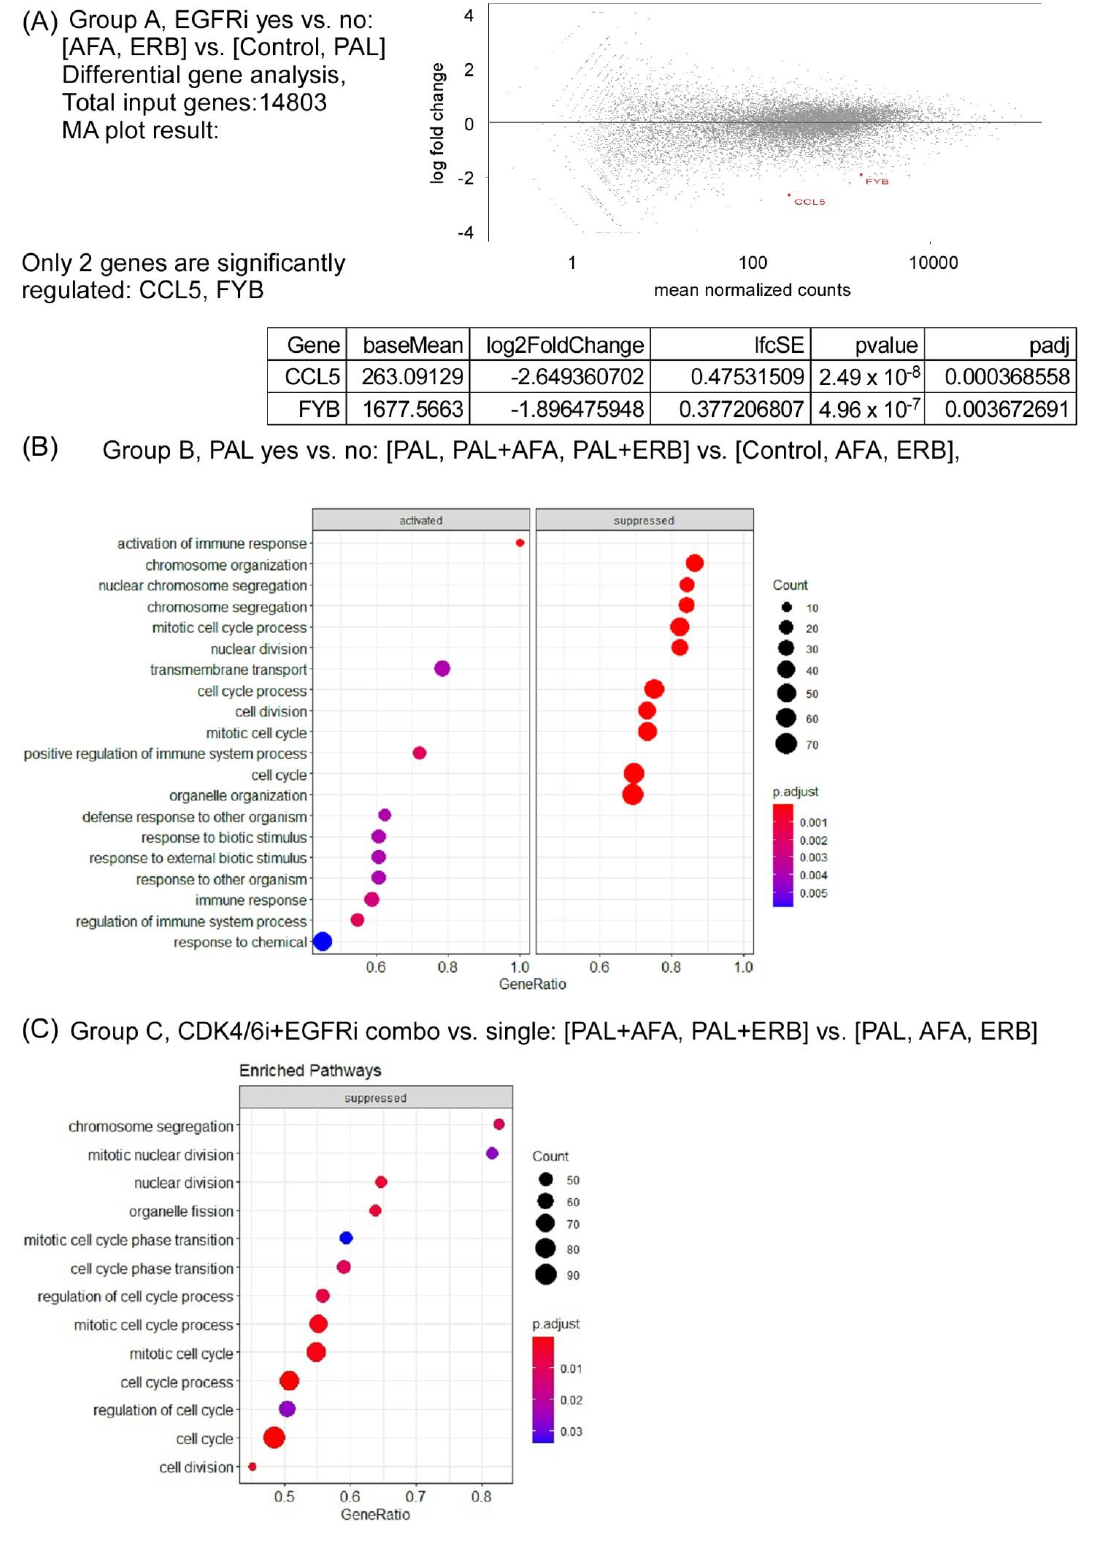
Figure 6. Bulk RNA sequencing of NPC PDX with or without EGFRi and/or CDK4/6i treatment. ( A ) Group A, EGFRi yes vs. no: (AFA and ERB0 vs. (Control and PAL); ( B ) group B, PAL yes vs. no: (PAL, PAL + AFA, and PAL + ERB) vs. (Control, AFA, and ERB); ( C ) group C, CDK4/6i+EGFRi combo vs. single: (PAL + AFA and PAL + ERB) vs. (PAL, AFA, and